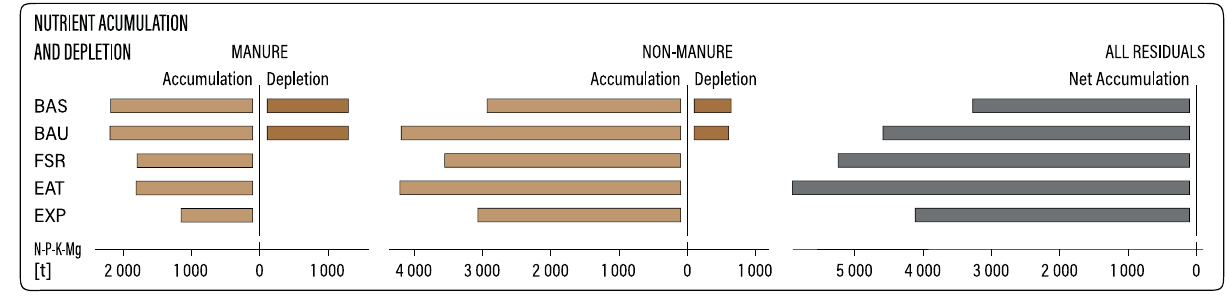
FIGURE 7 | Nutrient accumulation and depletion across food system scenarios. Note that the numbers for all four considered nutrient elements were added